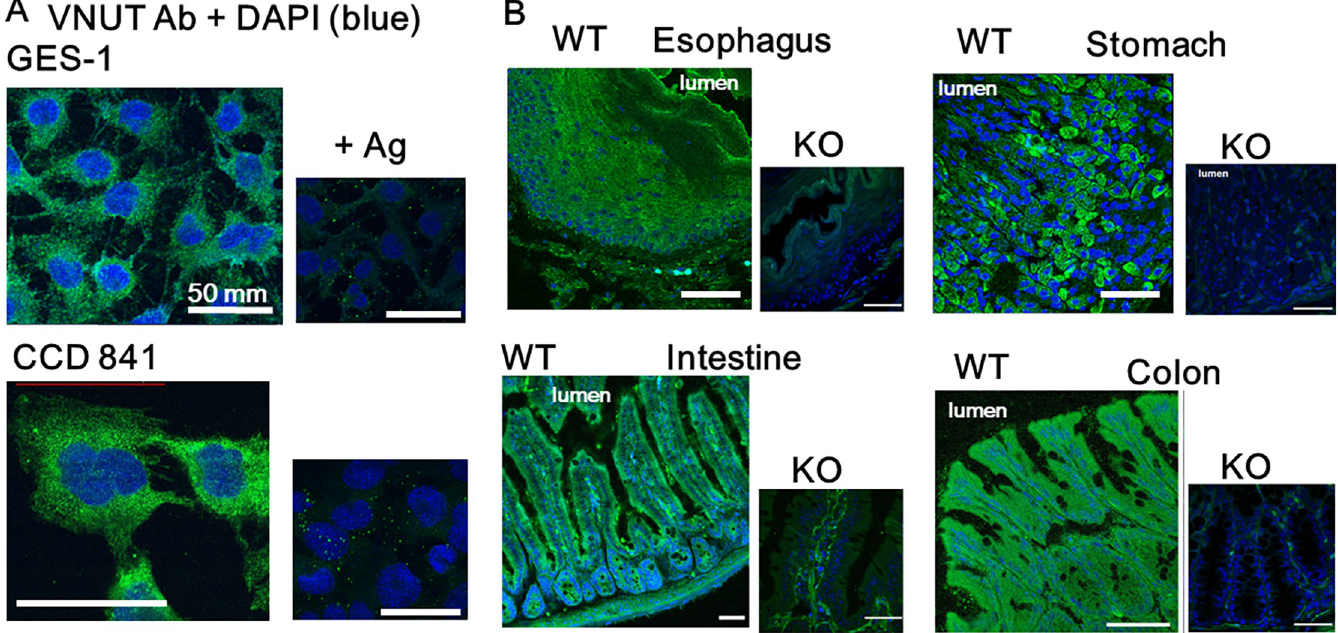
Fig 2. VNUT protein expression in human cell lines and mouse tissues. (A) VNUT expression was observed in GES-1 and CCD 841 cell lines. The punctate immunoreactivity was diminished with antigenic peptides (+Ag). (B) VNUT expression was observed in WT tissues (esophagus, stomach, intestine and colon) but not in VNUT-KO tissues. Scale bars indicate 50 μ m. DAPI indicates cell